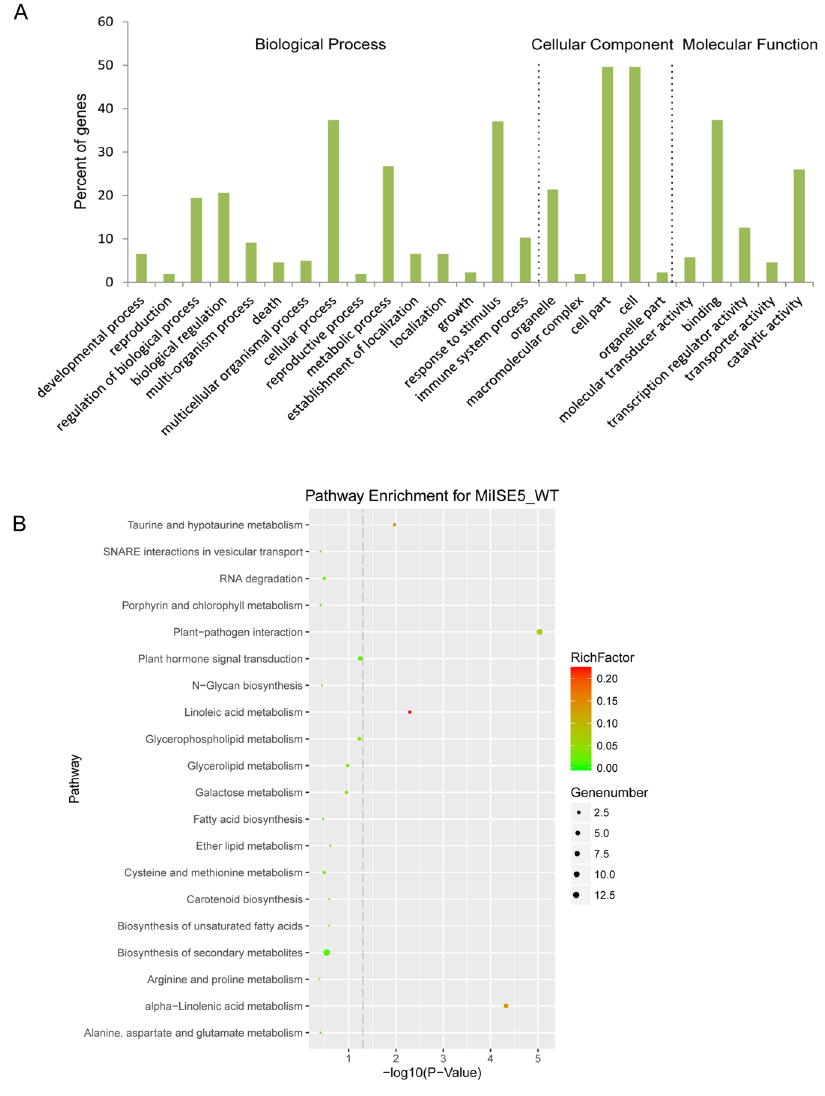
Figure 8. GO and KEGG enrichment of DEGS. ( A ) Gene Ontology (GO) enrichment of DEGs. ( B ) Scatter diagram of KEGG pathways. The y-axis represents the KEGG pathways. The color of the dot represent the “enrichment factor”(RichFactor), which indicates the ratio of the proportion of all genes annotated to a pathway to the proportion of the DEGs annotated to a pathway. The size of the dot indicates the number of DEGs grouped to the pathway. The x-axis represents the P value, with points near the left in the figure being more